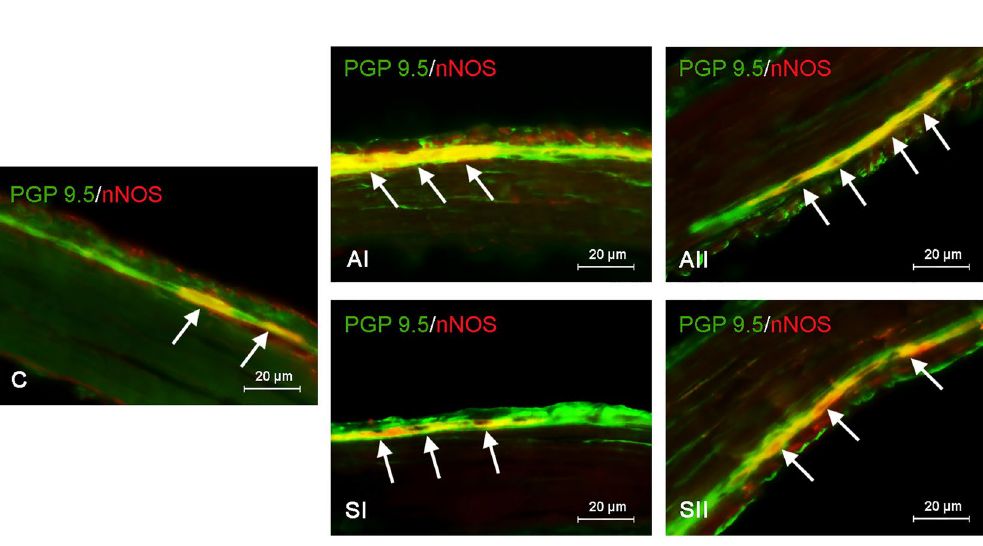
Figure 1. Distribution pattern of nerve cells immunoreactive to protein gene-product 9.5 (PGP 9.5)—used as a pan-neuronal marker and neuronal isoform of nitric oxide synthase (nNOS) in the myenteric plexus (MG) of the mouse stomach under physiological conditions (C) and after administration of bisphenol A in a lower (AI) and higher dose (AII) and bisphenol S in a lower (SI) and higher dose (SII). The pictures are the result of the overlap of both stainings. The arrows are pointing to neurons immunoreactive for both—PGP 9.5 and